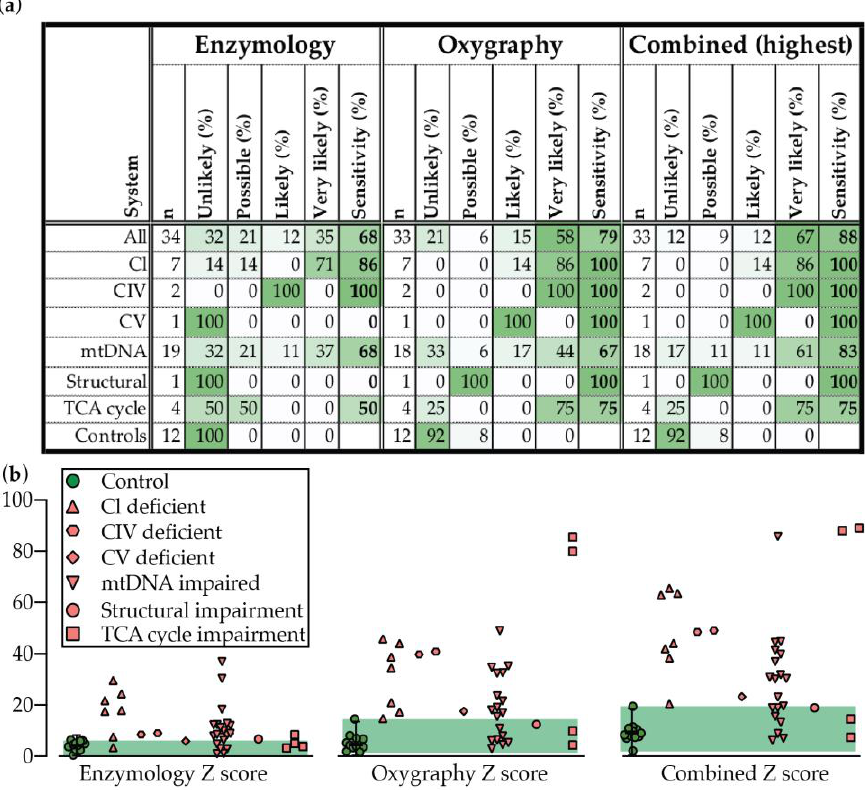
Figure 4. Disease prediction and sensitivity for enzymology, oxygraphy, or combined methods for detecting PMD as presented ( a ) in a table, or ( b ) through the plotting of the combined positive Z scores for each test and combined value. Median is displayed for controls with error bars showing the 1.25th and 98.75th percentiles of the reference range, and the green shading region shows the range. Abbreviations: CI–CIV, respiratory chain complexes I–IV.